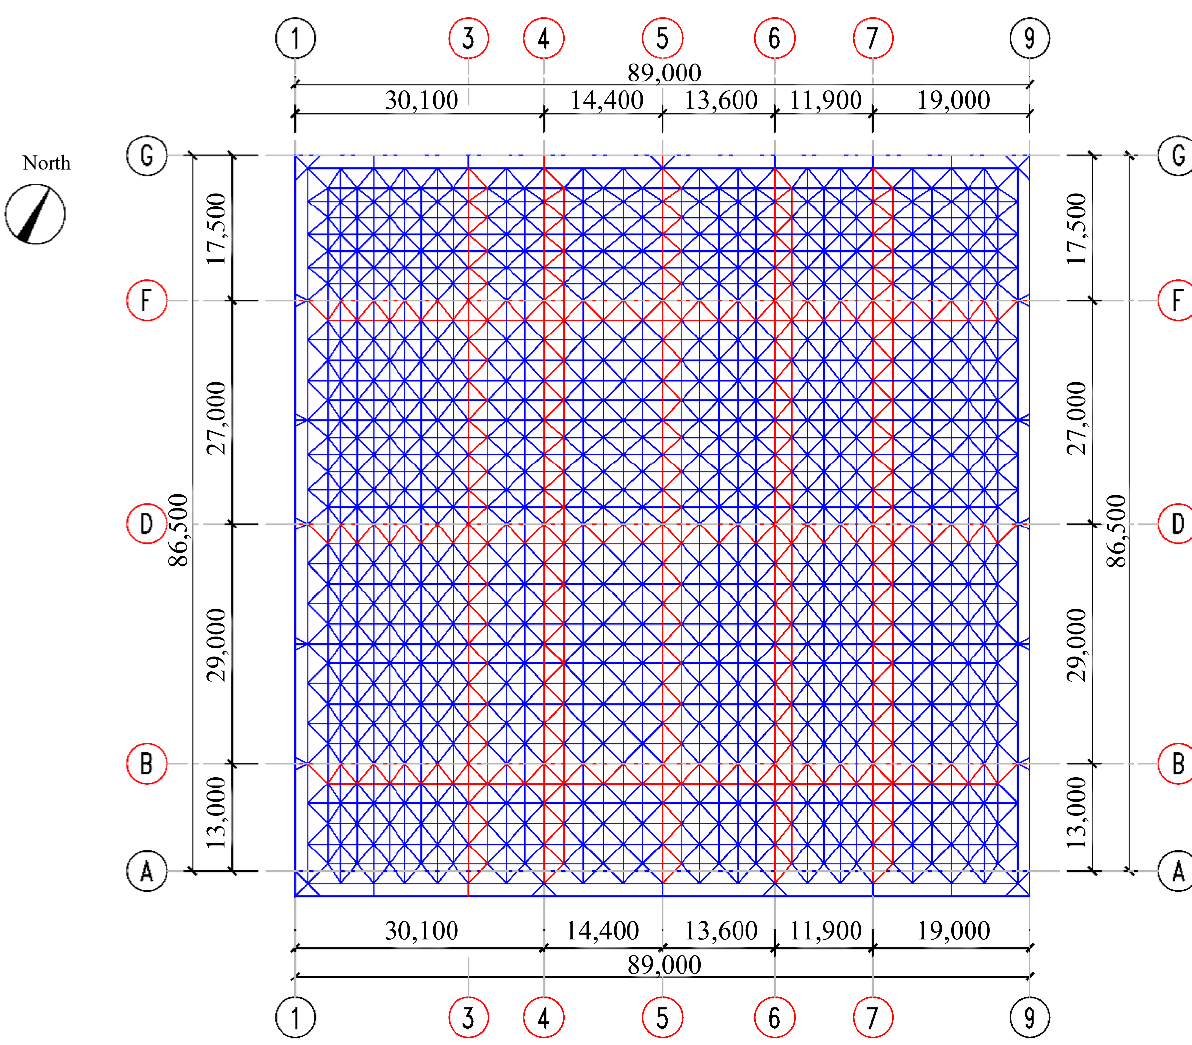
Figure 6. Layout of monitoring points. (Note: the red part of the figure is the monitoring area.)